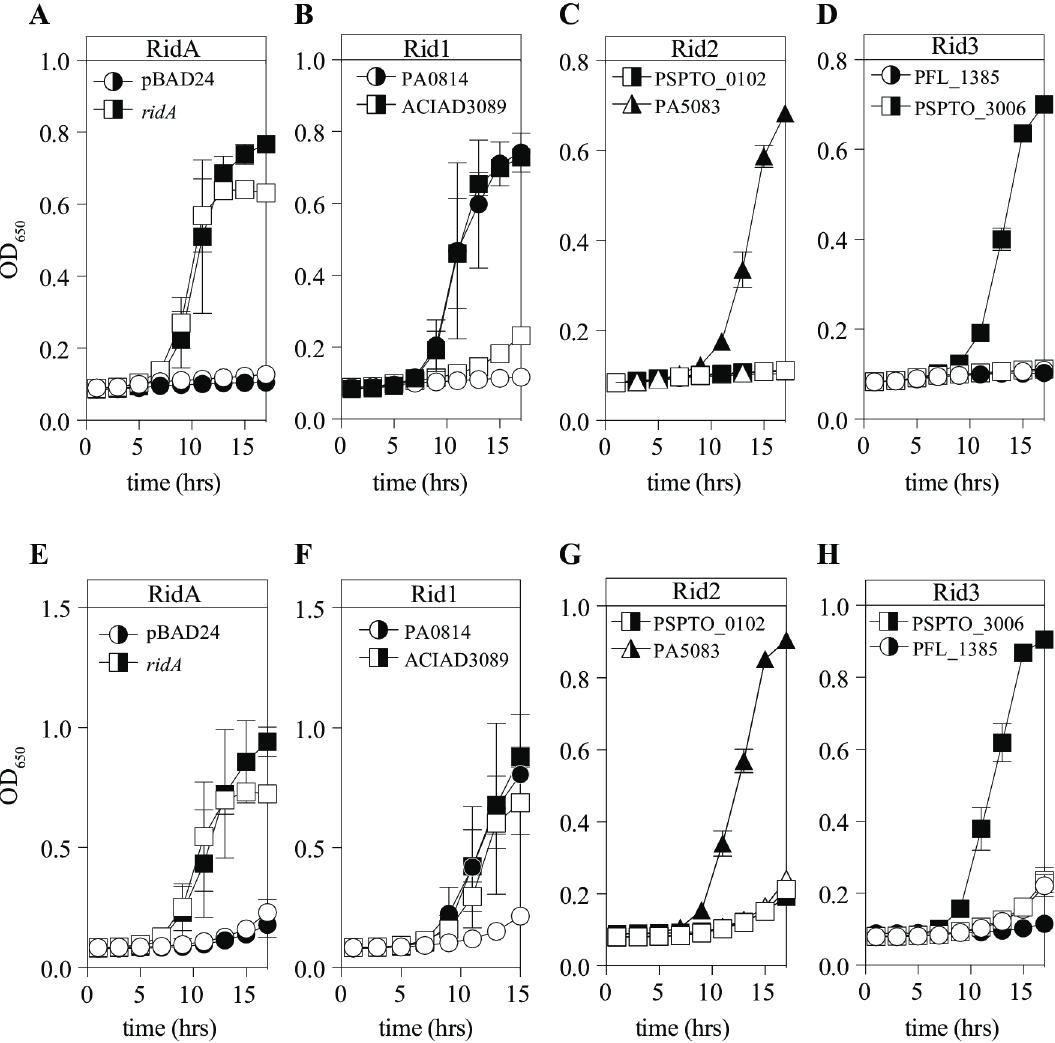
Fig 4. Representative RidA and Rid1 proteins rescue growth of S . enterica ridA mutant strain. An S . entericaridA strain (DM12920)was transformed with pBAD24constructs harboringno insert (pBAD24), S . enterica ridA , P. aeruginosa PA0814, A . baylyi ACIAD3089, P . syringae PSPTO_0102, P . aeruginosa PA5083, P . fluorescens PFL_1385, or P . syringae PSPTO_3006. The strains were grown in minimalglycerol medium supplemented with (A-D) 5 mM serine or (E-H) 250 μ M cysteine, with (closedsymbols) or without (open symbols) arabinose.The correspondingRid subfamily assignment is presented aboveeach graph. Growth was monitored by opticaldensity at 650 nm with shakingat 37˚C. Error bars indicatestandard deviationfor three